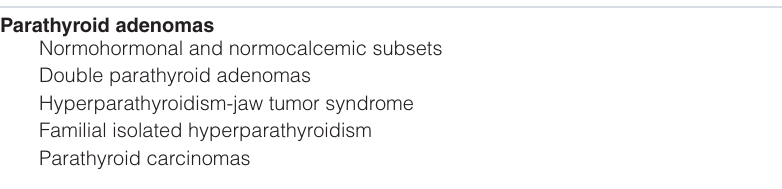
Table 1. Classification of primary